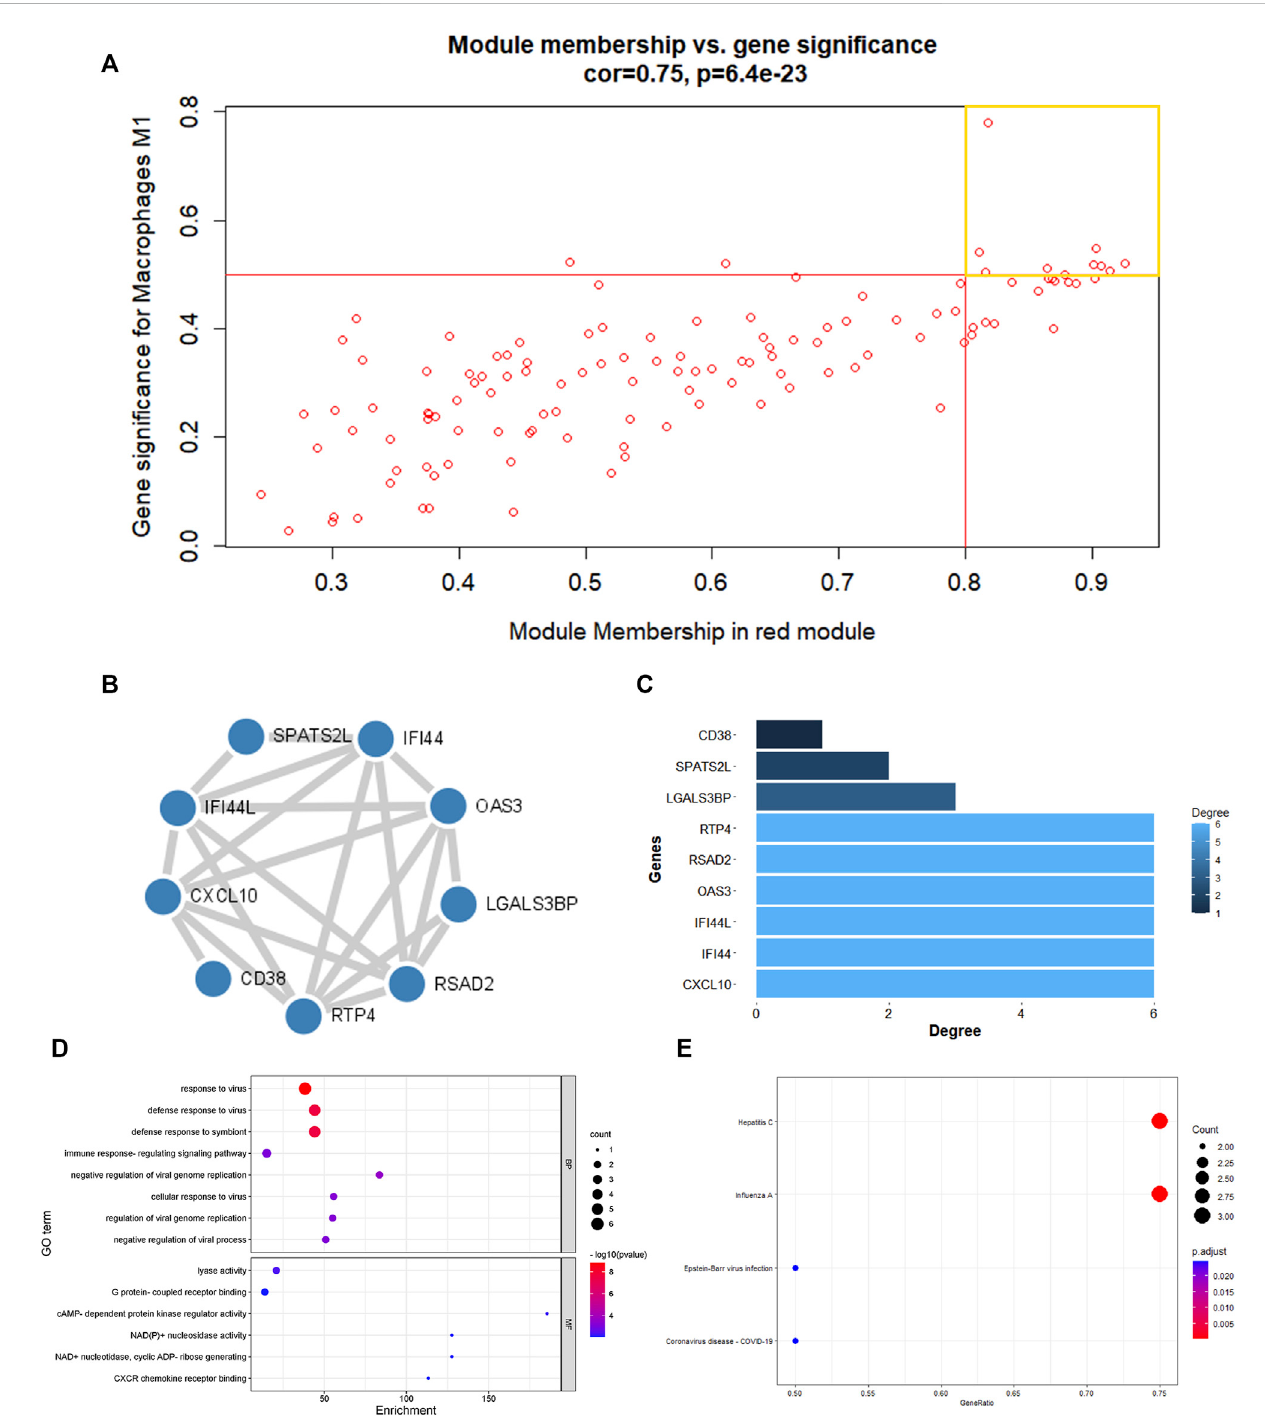
FIGURE 3 PPI network establishment and enrichment analysis of hub genes. (A) A scatter diagram of genes in red modules. Each red dot stood for a gene, spot inside the yellow box implied genes of Module Membership > 0.8 and Gene Signi fi cance > 0.5. (B) PPI network were construction and circular nodes stood for hub genes. (C) Bar graph shown the number of protein interactions in PPI network. (D) The GO items of hub genes. (E) The KEGG pathway of hub